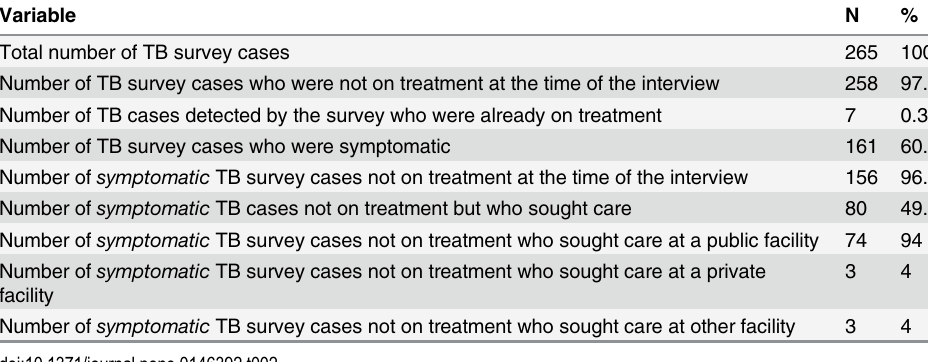
Table 2. Health seeking and treatment status of survey cases. Variable